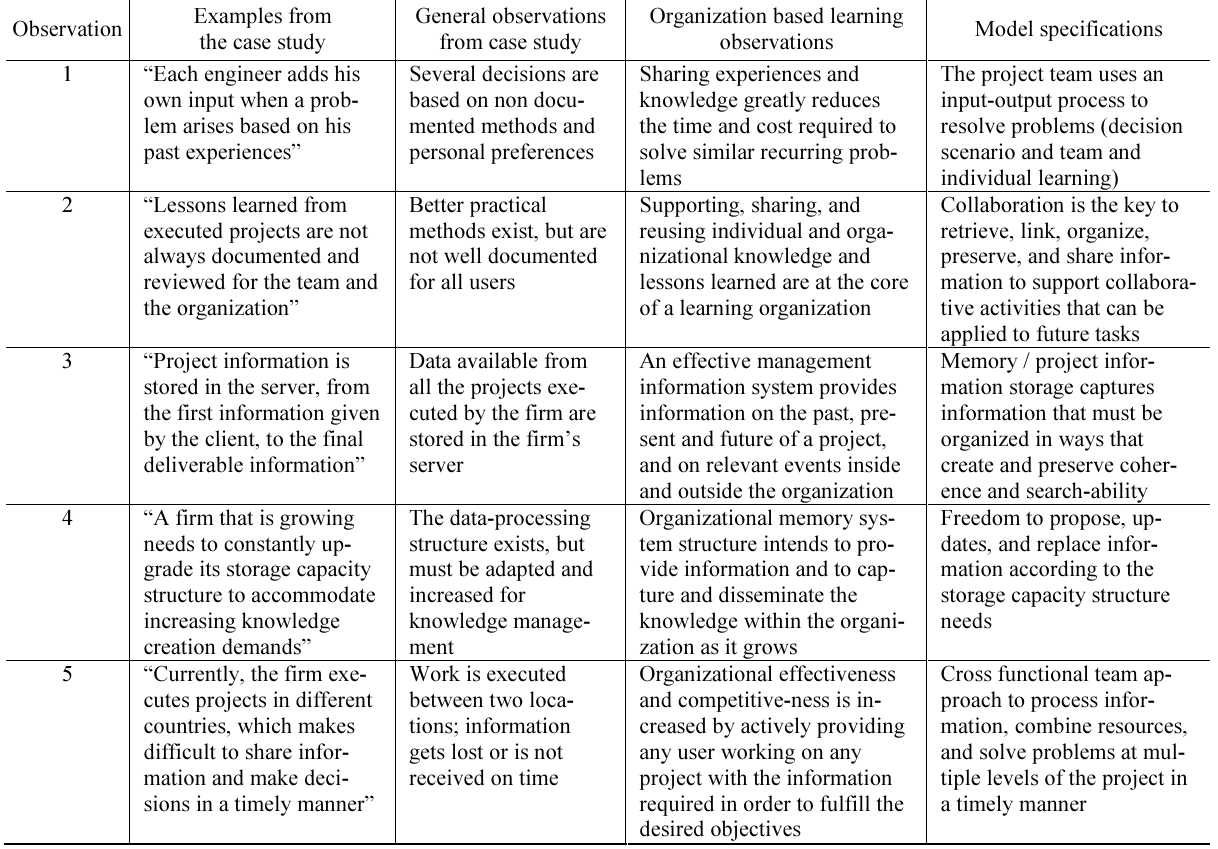
Table 1. Summary of organizational memory based learning mechanism – observations